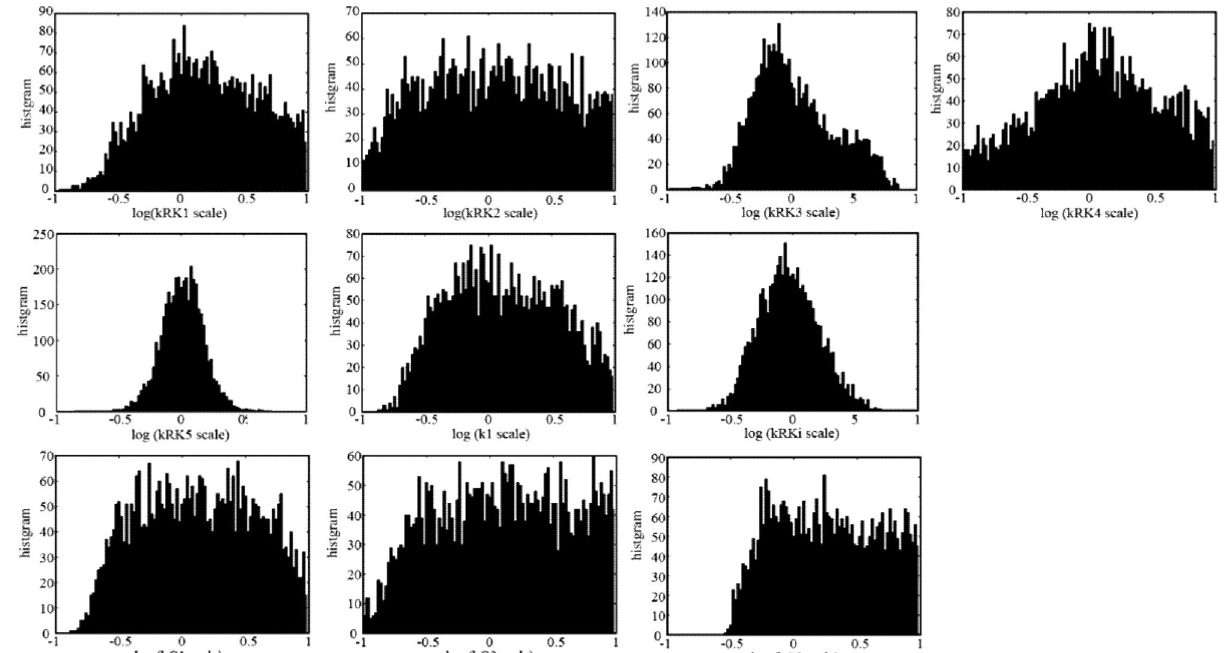
Figure 6. Histogram of phosphoryration related parameters of random test in rods. Histogram of phosphorylation related parameters of random test in rods are shown. The random test was performed by generating 21 uniform log linear distribution random number between 0.1 to 10.0 for phosphorylation related parameters ( k RK1 , k RK2 , k RK3 , k RK4 , k RK5 , k RK6 , k RKi , k 1 , k G1 , k G2 , k G3 , k G4 , k G5 , k G6 , k G7 , k P1 , k P2 , k P3 , k P4 , k decay ,